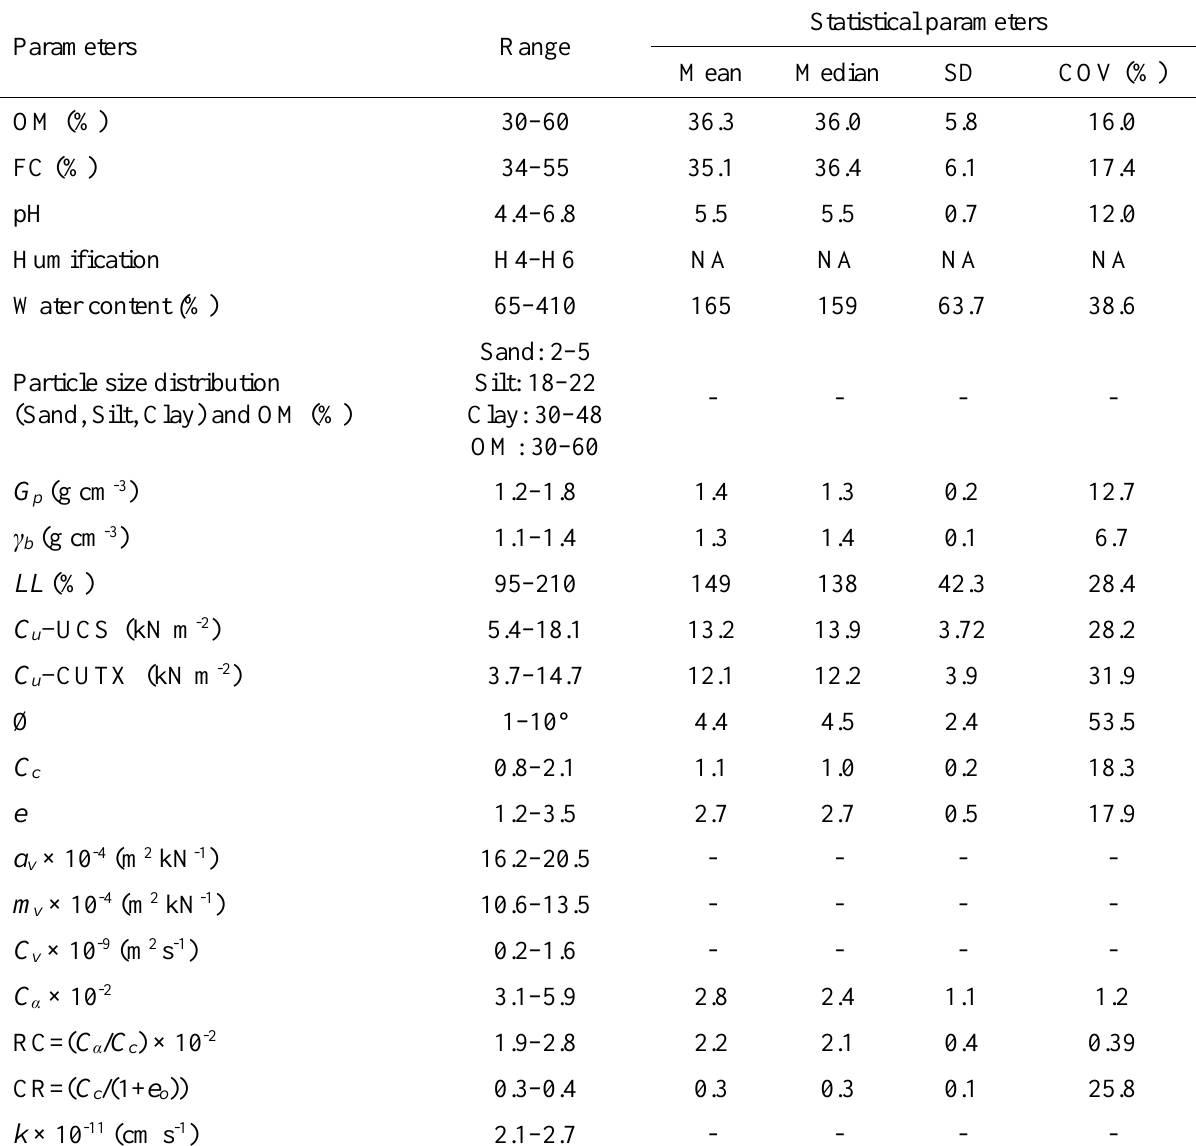
Table 2. Physiochemical and engineering parameters of Agartala peat samples along with statistical parameters. OM = organic matter, FC = fibre content, pH = potential of hydrogen, G p = specific gravity, γ b = bulk density, LL = liquid limit, C u = cohesion, Ø = angle of internal friction, C c = compression index, e = void ratio, a v = coefficient of compressibility, C v = coefficient of consolidation, C α = secondary consolidation, m v = volume compressibility, RC = ratio of compression, CR = compression ratio, k = permeability coefficient, SD = standard deviation, COV = coefficient of variation, NA = not